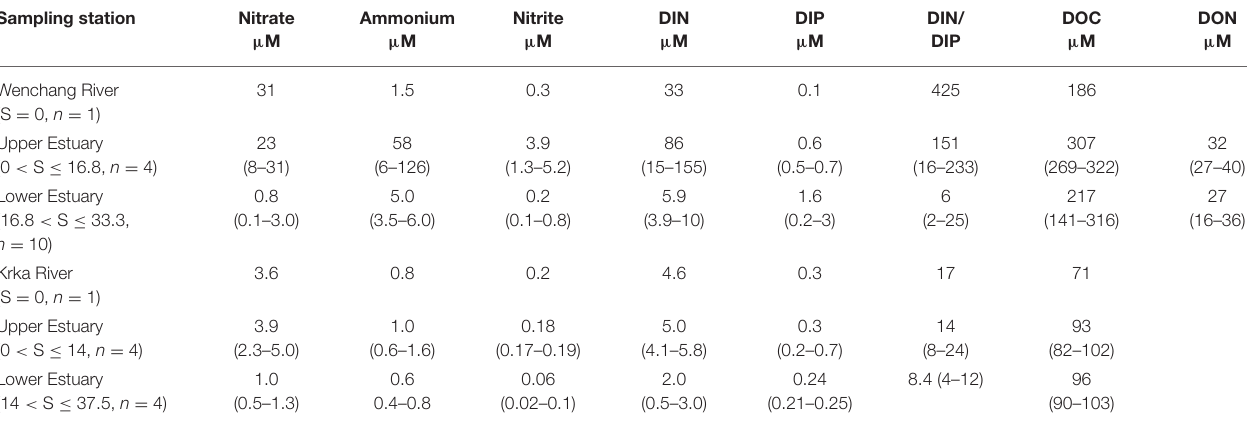
TABLE 1 | Nutrients and dissolved organic matter (OM) in surface waters of the Wenchang River Estuary. Sampling station